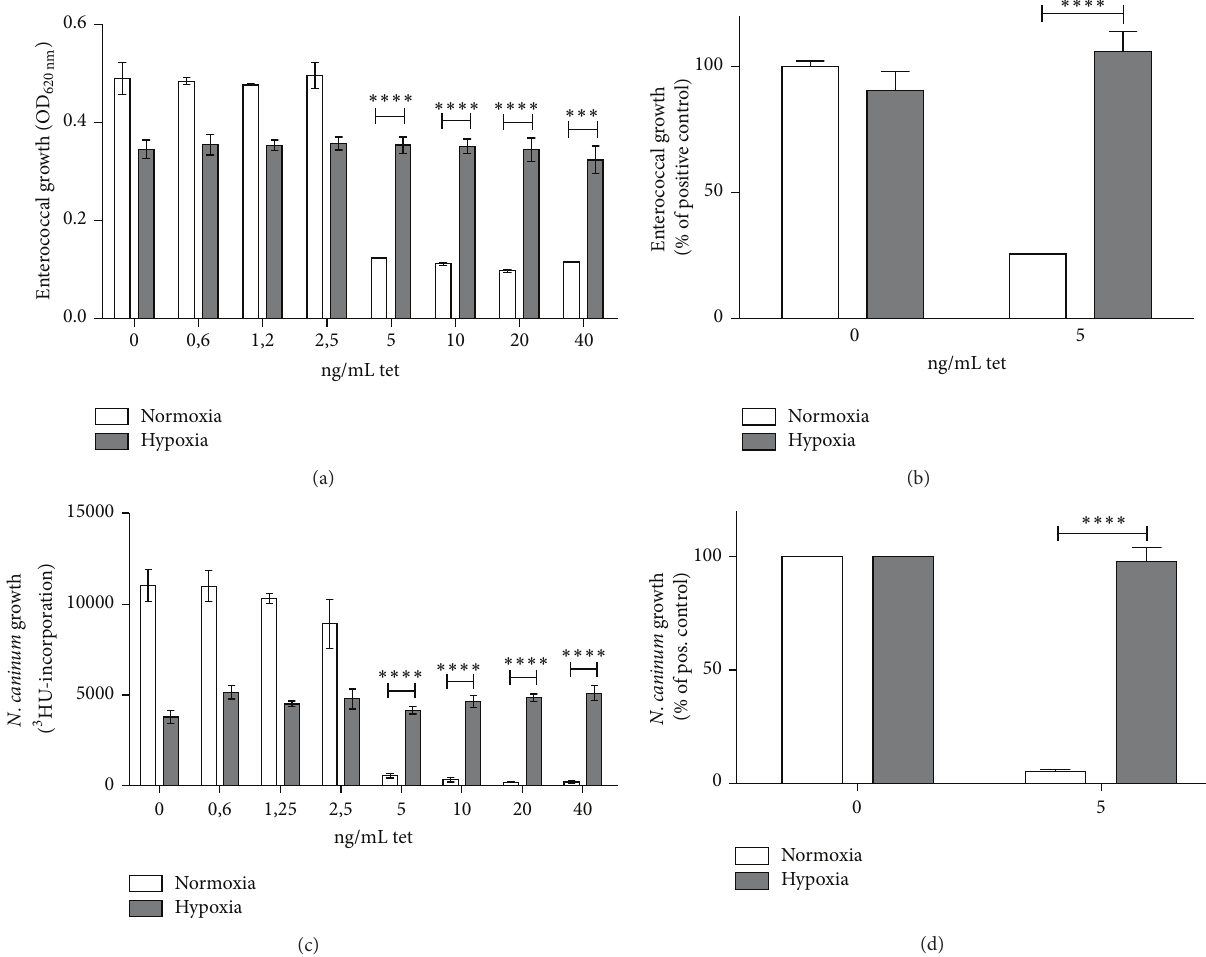
Figure 4: Loss of TDO-mediated antimicrobial functions in HeLa-hTDO cells under hypoxic conditions. Infection experiments: following 72 h prestimulation with denoted amounts of tetracycline, HeLa-hTDO cells infected with Enterococcus faecalis (a and b) or Neospora caninum (Nc-1 strain) (c and d). After 24h the bacterial growth or after 48 h the parasite growth was determined by measurement of OD 620 nm or by the 3 H-uracil incorporation method, respectively. (a and c) Single experiment with three replicates and (b and d) summary of three independent experiments with three replicates each. A significant decrease of microbial growth under hypoxia as compared to the normoxia control is marked with asterisks ( ∗∗∗ 𝑝 ≤ 0.001 ; ∗∗∗∗ 𝑝 ≤ 0.0001 ) and was calculated by a two-tailed, unpaired t -test. The bars indicate the mean value ± SD (a and c) or ± SEM (b and